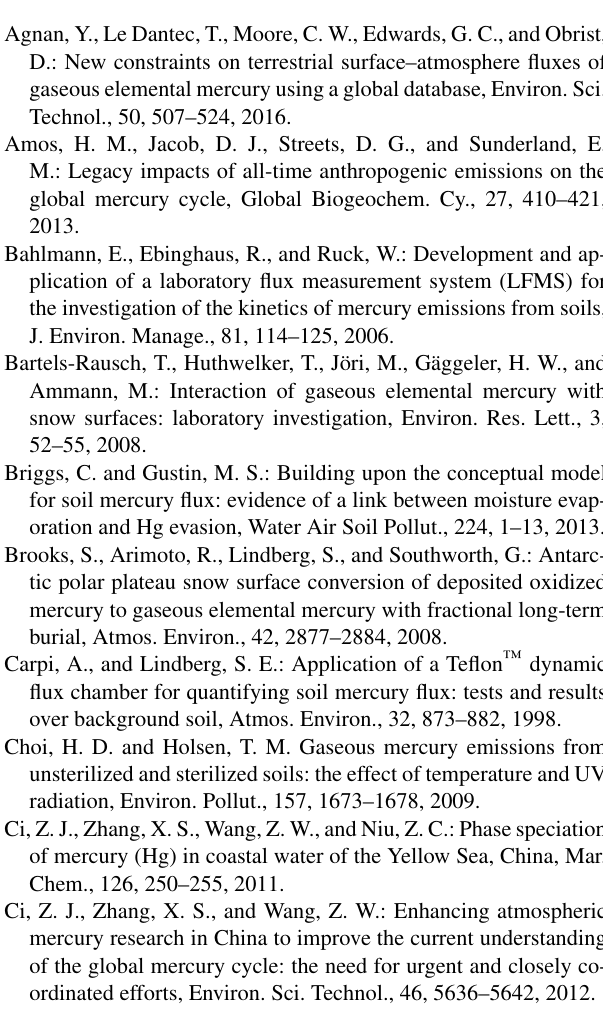
precipitation, greatly influenced the Hg(0) exchange between air and